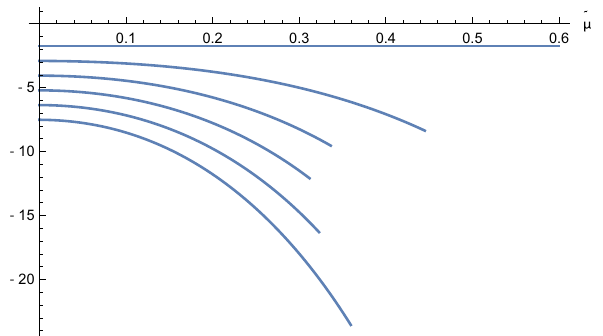
Fig. 3 Contourplot(leftpanel)oftherealpartoftheeffectivepotential with chemical potential ˜ μ = 0 . 4 and g = 4, N f = 3, to be compared with Fig.2 (right panel). Section at x = 0 (right panel), to compare